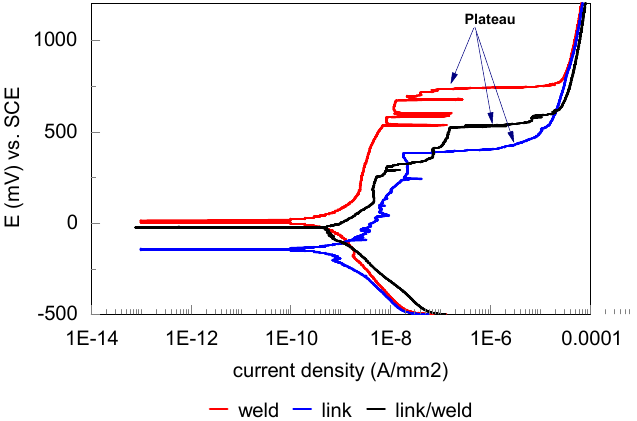
Figure 12. The average potentiodynamic polarization curves for the weld, link and link/weld inter- face areas. Sample #3.